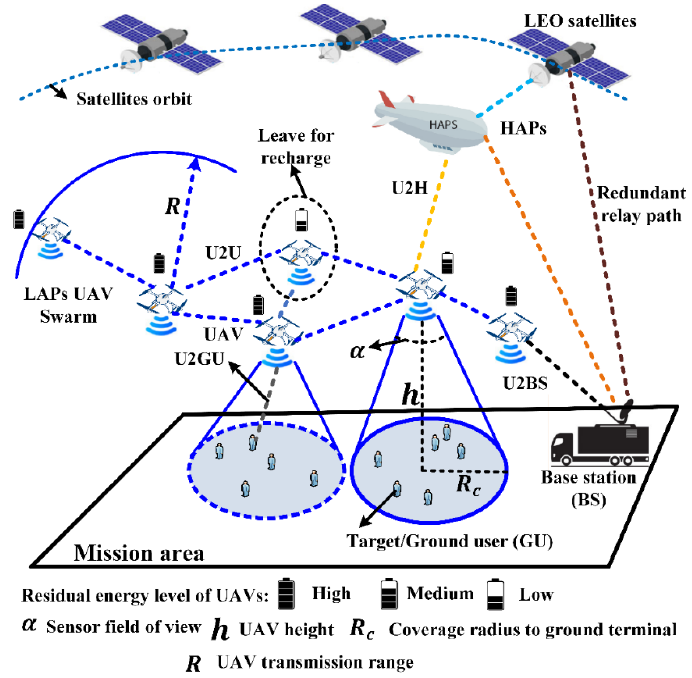
Figure 1. FANET and its different components.